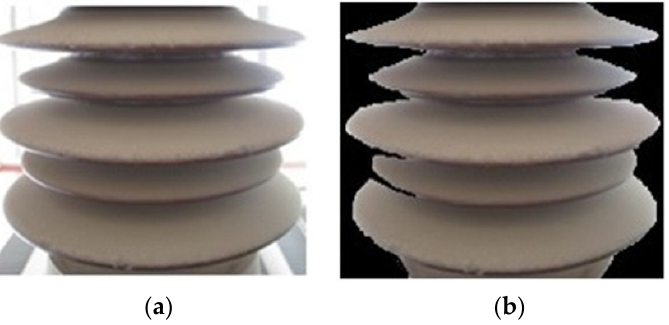
Figure 5. The result of disk surface extraction: ( a ) original image; ( b ) processed image.